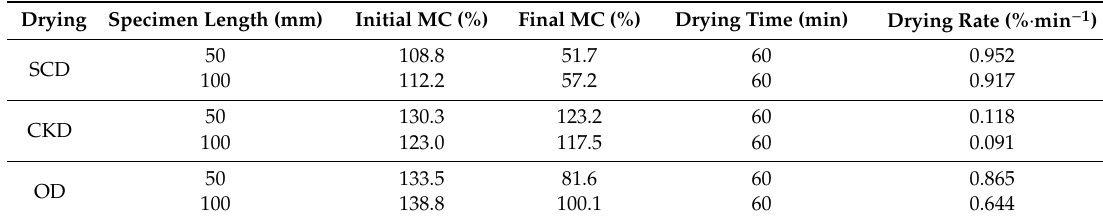
Table 2. Drying rate of specimens under di ff erent drying methods.